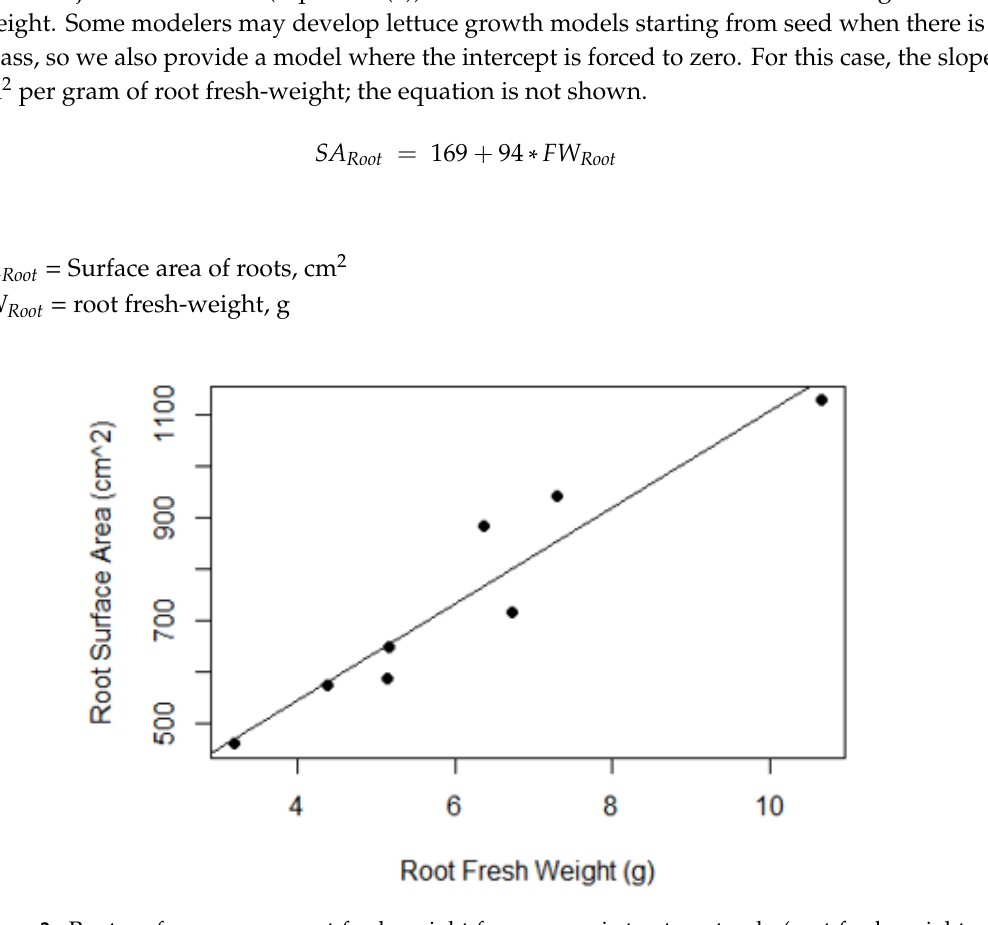
Figure 3. Root surface area vs. root fresh weight for aquaponic treatment only (root fresh weight excludes weight in the rockwool cube).